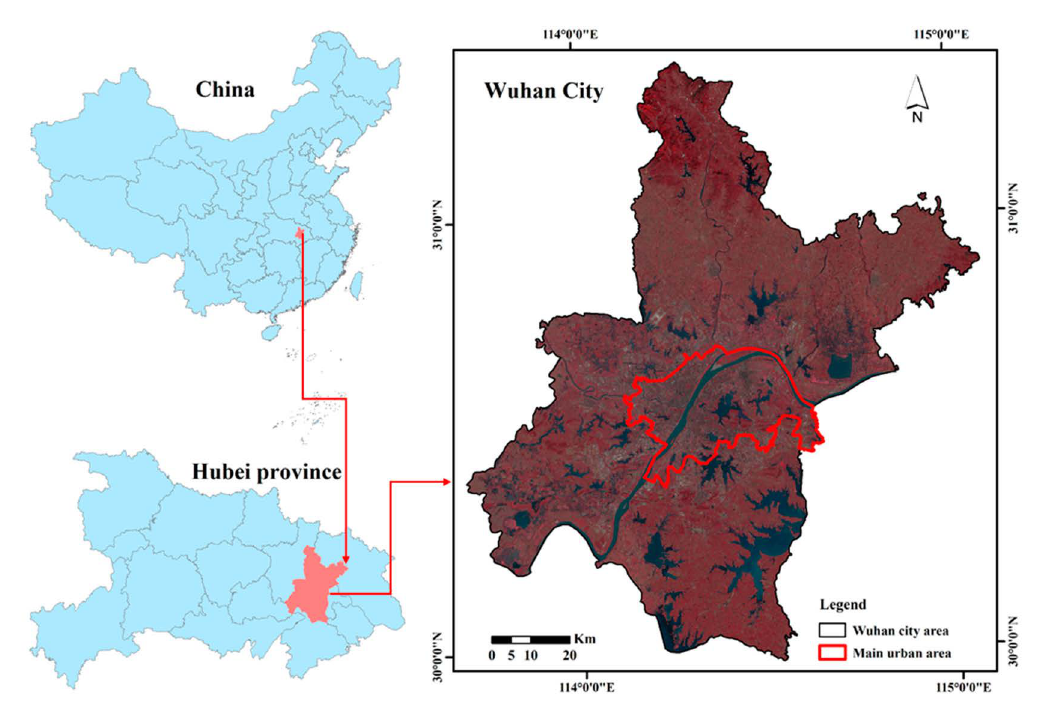
Figure 1. The location and administrative boundary of Wuhan city. The background image on the right is the standard false color remote sensing image of Wuhan after